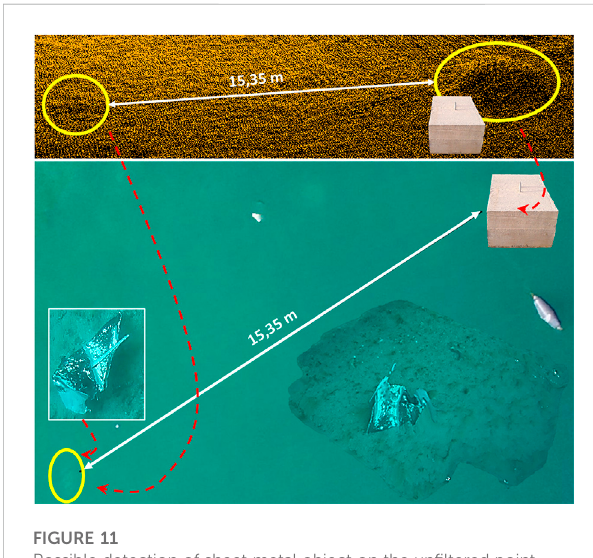
FIGURE 11 Possible detection of sheet metal object on the un fi ltered point